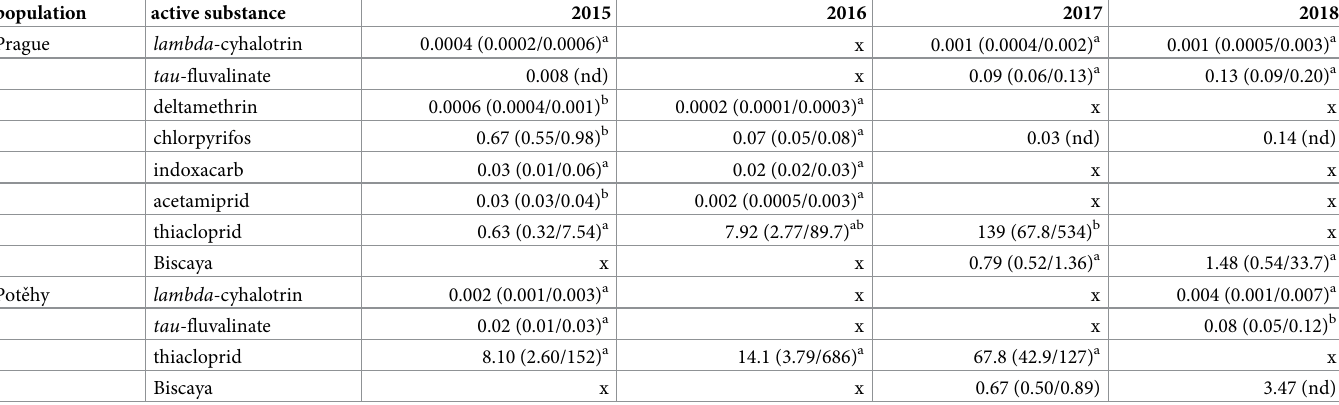
Table 3. Lethal concentrations LC50 ( μ g/cm 2 ) of active substances of insecticides and confidence limits (CL) calculated for populations of CSFB collected in Prague locality in 2015–2018. Values with different numbers for the same letters in the same line are significantly different (the CLs overlap). nd–no CL defined. x–no data